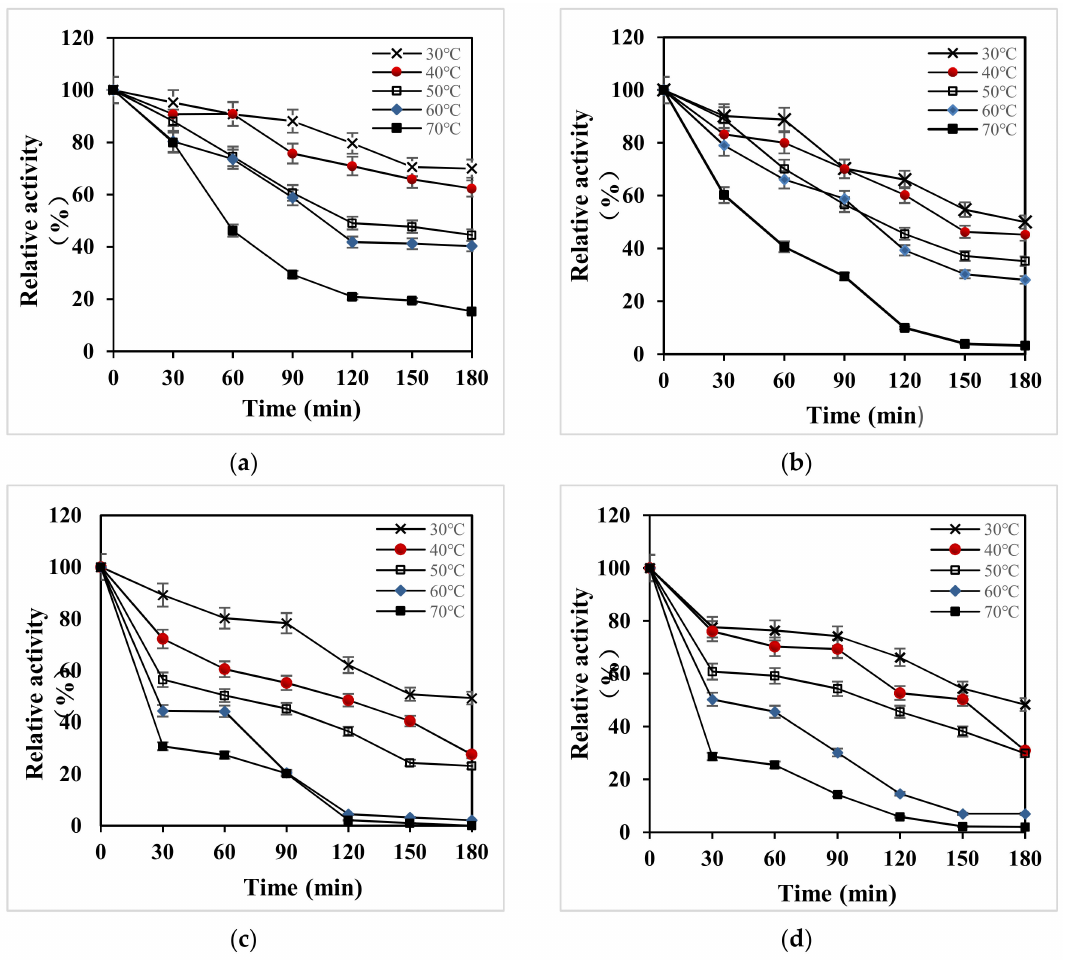
Figure 6. Temperature stability of all strains. ( a ) X33-Lac-2; ( b ) native Pleurotus ostreatus ; ( c ) X-33 Pichia pastoris ; ( d ) empty pGAPZ α A plasmid